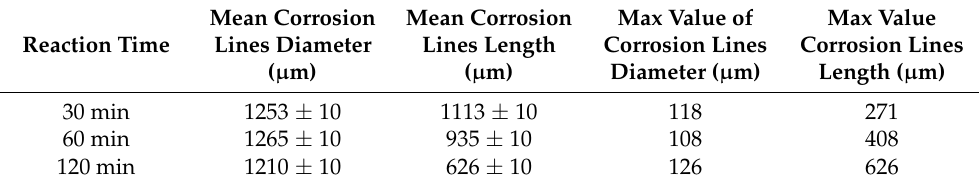
Table 2. Mean dimensions of the diameter and the lengths of the pellets and maximum values for diameter and length of corrosion lines as obtained by SEM image analysis at various dissolution times in peroxide solution